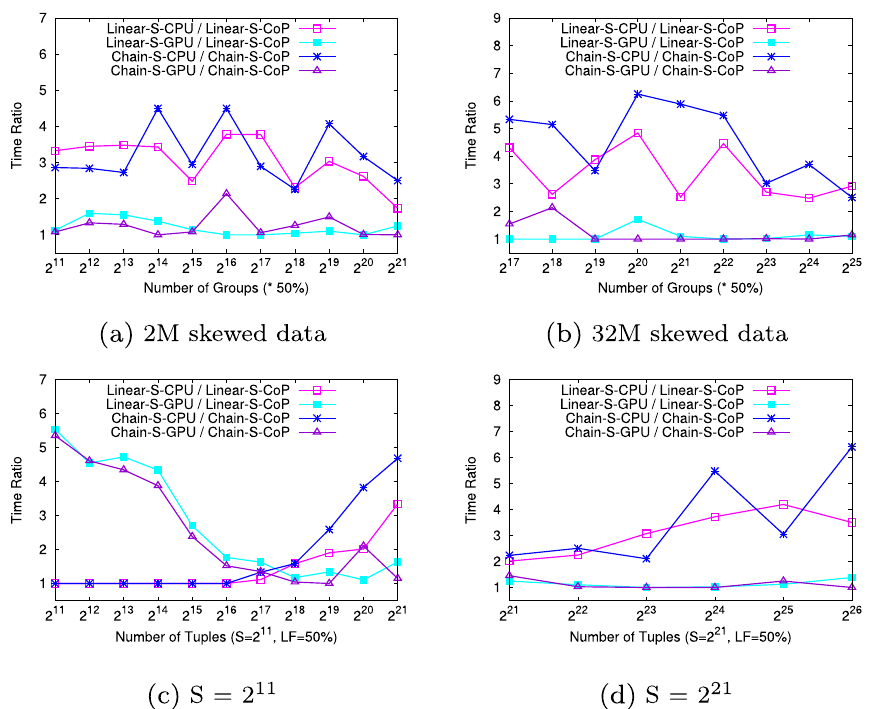
Fig. 17 Performance of the intra-operator co-processing strategy on the skewed